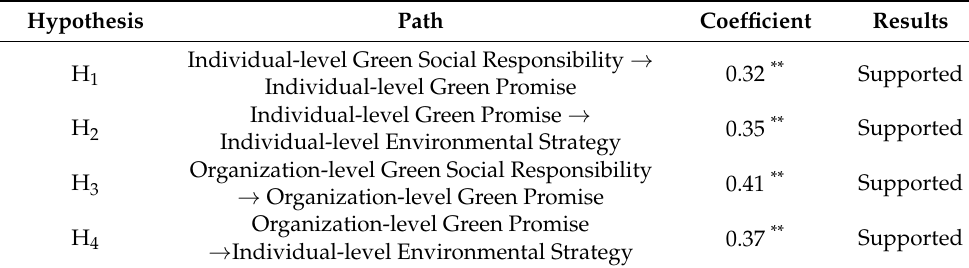
Table 1. Results of